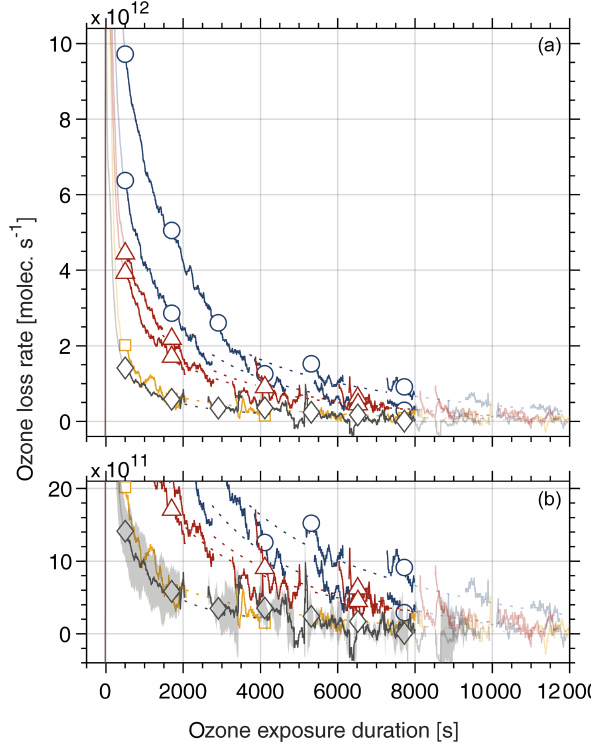
Figure 1. Ozone loss rate with duration of exposure. The snow sam- ples with a bromide concentration of 6.2µM experienced 0d (blue lines, open circles) and 12d (yellow line, open squares) of meta- morphism with a temperature gradient of 31 ◦ Cm − 1 . Panel (b) is a zoomed-in view of the data in panel (a) . Ozone data were recorded continuously (lines), and the markers are guides. The dotted lines are a guide for the eyes for periods when ozone loss data were not available (see text for details). Also shown are the ozone loss rates of snow samples after 12d of isothermal metamorphism at − 20 ◦ C (red lines, open triangles). The grey line (open diamonds) denotes the average ozone loss rates of five samples with no bromide added and with and without exposure to temperature gradient metamor- phism. The shaded area in panel (b) shows the standard deviation. The gas-phase mixing ratio of ozone varied between 4 . 7 × 10 12 and 6 . 2 × 10 12 molec.cm − 3 for individual samples. The tempera- ture during ozone exposure was − 15 ◦ C. At time 0, ozone in the carrier gas was passed over the snow